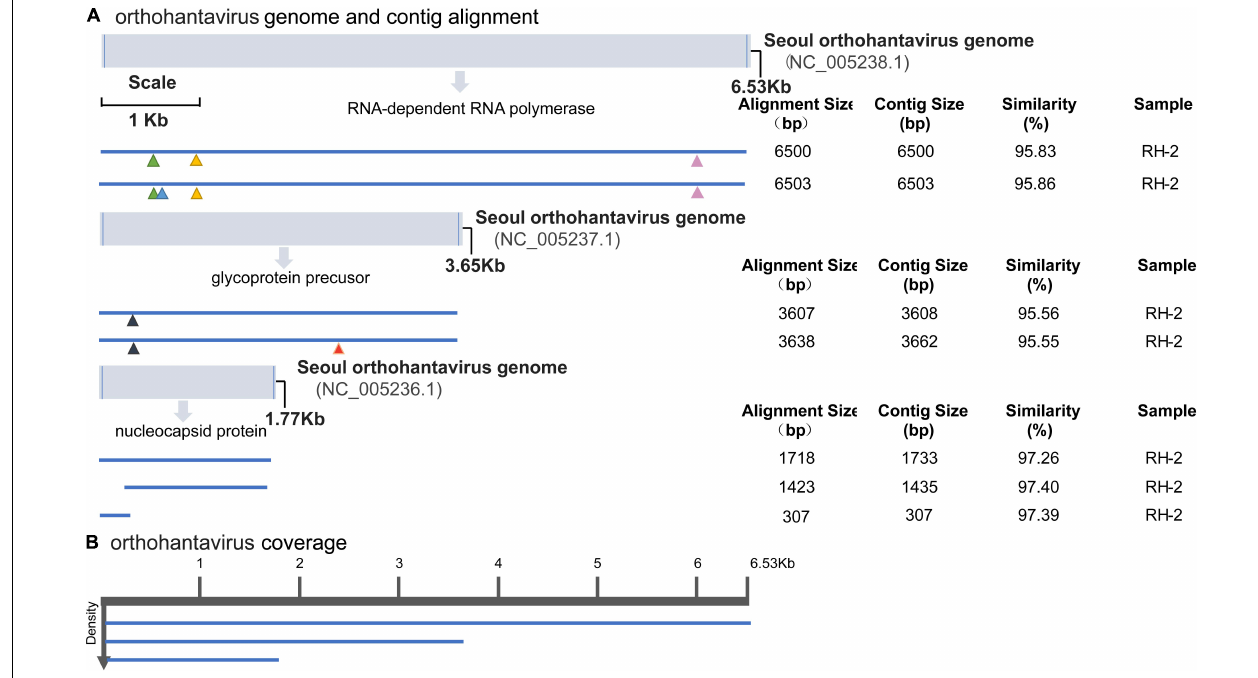
FIGURE 3 | Hantavirus genome organization and mapping of de novo –assembled contigs. (A) Coordinates are based on the reference sequence number X14736.2. Open-reading frames are represented by cylinders. Genomic RNA is represented by a solid line. Colored triangles mark the amino acid site substitutions. For every sample categorized as infected, the longest contig is shown. Shorter, redundant contigs are not illustrated. Contig size, alignment size, and similarity (%) are indicated. (B) Genome coverage after reference-based assembly using Bowtie v2 for one representative sample. Sequence density is indicated on the left.